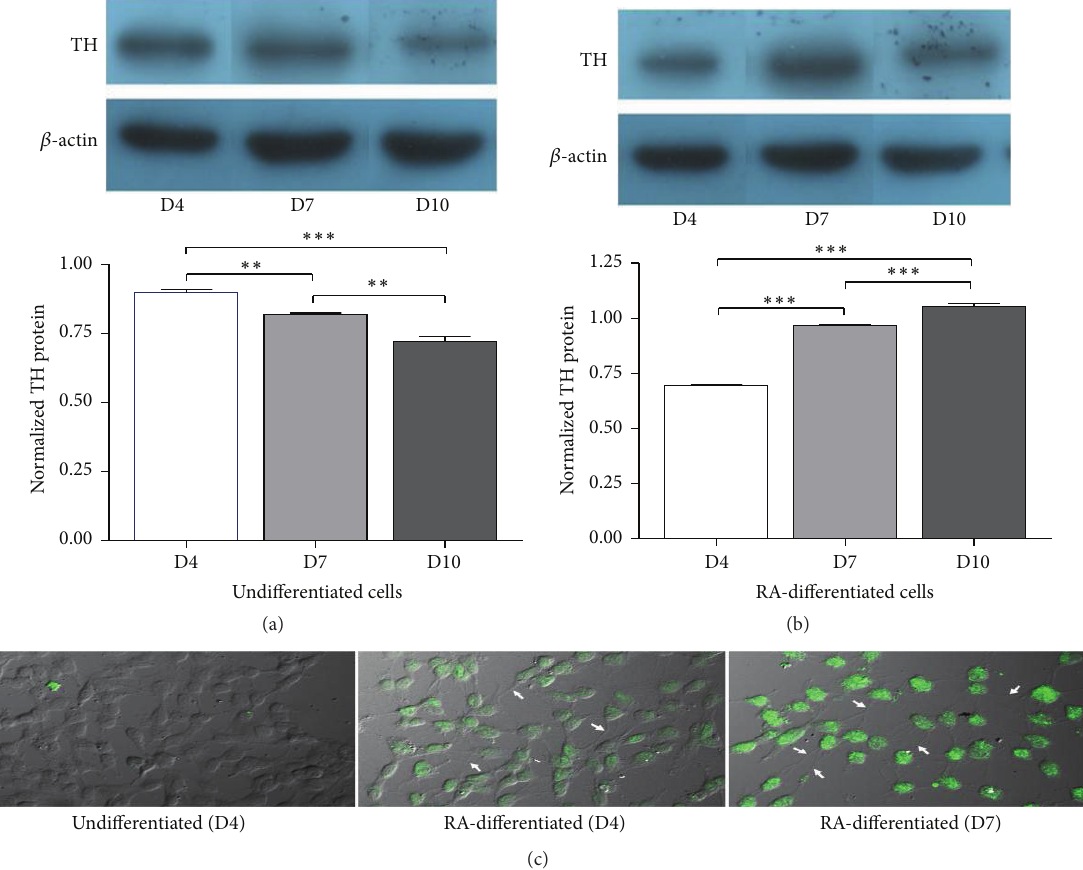
Figure 2: Expression of tyrosine hydroxylase in undifferentiated and differentiated SH-SY5Y cells. Cells were differentiated in 10- 𝜇 M retinoic acid (RA). After differentiation for 4, 7, and 10 days, tyrosine hydroxylase (TH) was detected with western blotting (a and b). The density of bands was analyzed in comparison with that of 𝛽 -actin. Data are expressed as mean ± SEM ( 𝑛 = 3 ). ∗∗ 𝑃 < 0.01 ; ∗∗∗ 𝑃 < 0.001 . Expression of TH was visualized through immunostaining in undifferentiated cells and 4- and 7-day RA-differentiated cells (c). White arrows indicate areas of neurite